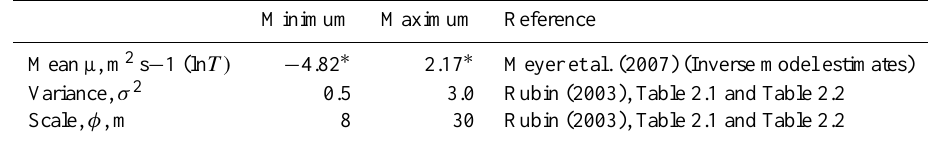
Table 1. The lower and upper bounds of the prior distribution for the structural parameters of the 2-D transmissivity field.